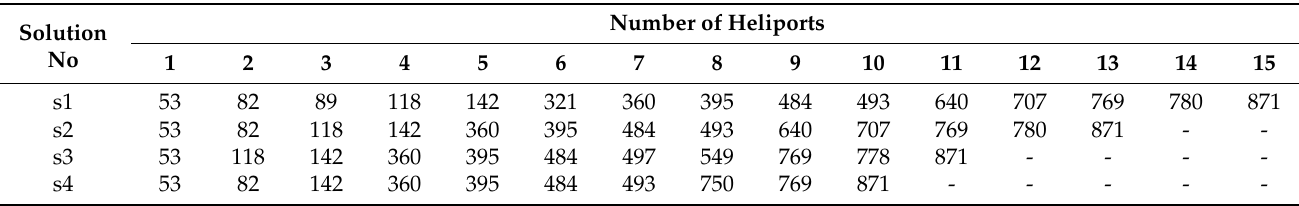
Table 2. Grid numbers of optimum heliport locations in the Pareto optimal